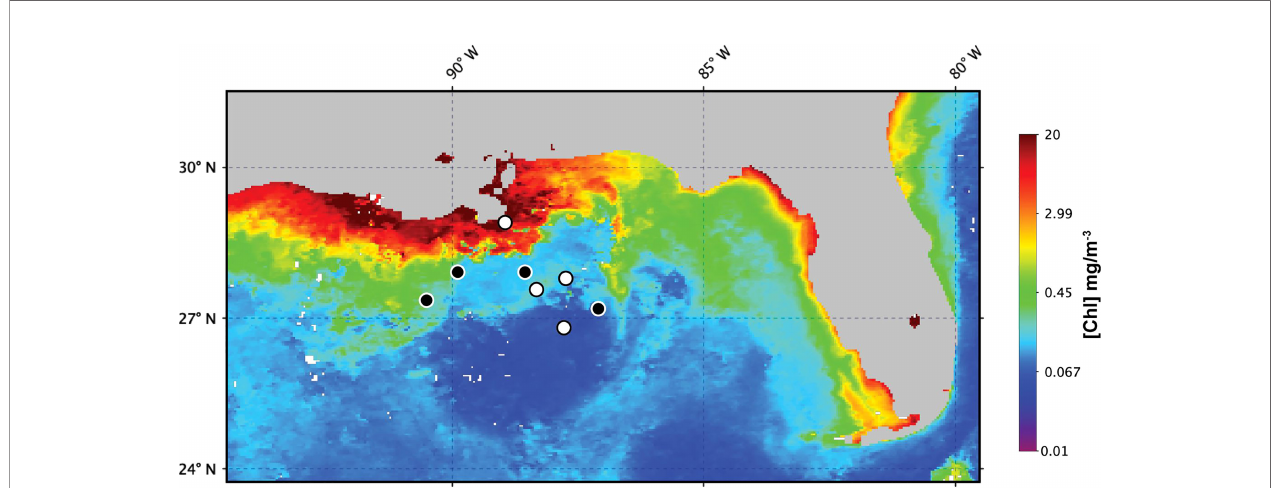
FIGURE 1 | Gulf of Mexico sites sampled for measurements of cell-speci fi c Chl a during EN642. Numbered black circles indicate sites where pro fi le samples were collected. White circles indicate sites where only surface samples were collected. Background chlorophyll concentration corresponds to the 4-km, 1-month MODIS composite for July